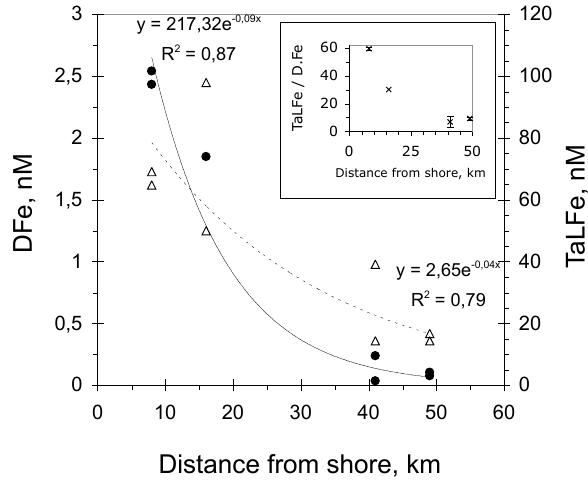
Fig. 8. Concentrations of Fe used to estimate scale lengths for dis- solved and total acid leachable Fe. Exponential regressions were used to fit to data (curved lines) from four coastal stations (#8–9, 15–16) to determine the scale lengths for DFe ( 4 , dashed line) and TaLFe ( • , solid line). Equations for each regression are shown. Only surface values ( < 50m) were used in these regressions. The inset shows the variation of TaLFe: DFe ratios with distance from